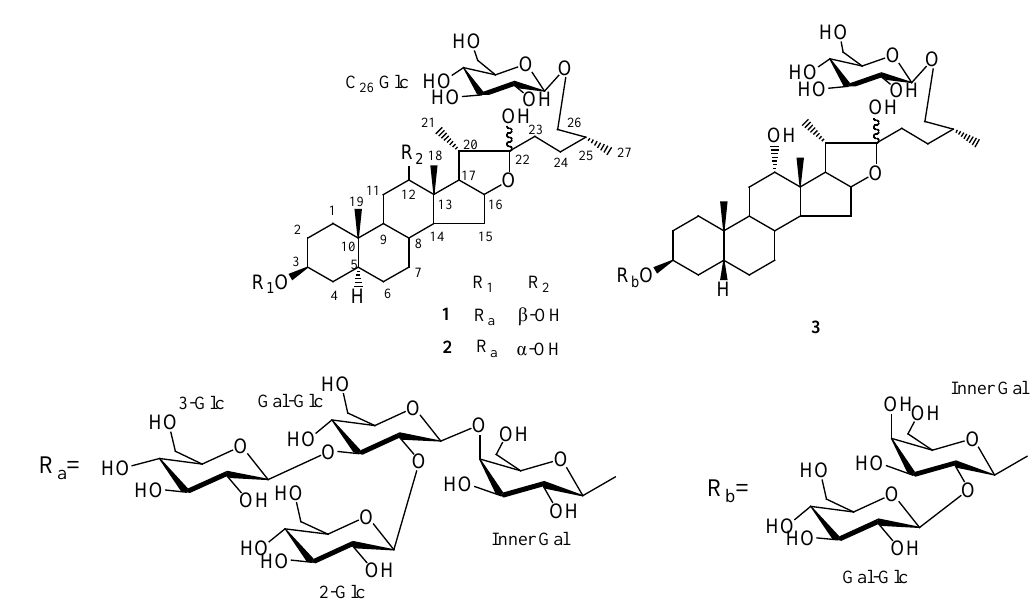
Figure 2. The structures of compounds 1 – 3